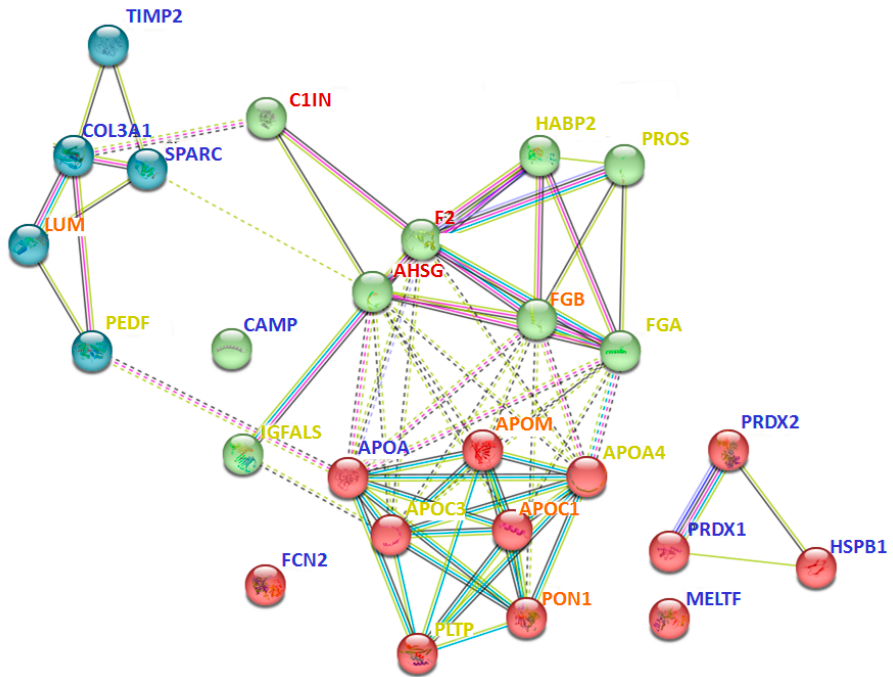
Figure 6. Interaction analysis of some of the potential urinary protein markers prevalent only in certain groups (Table 2), using the STRING method. The red cluster corresponds to different processes associated with lipid metabolism; the green cluster relates to immune processes; the blue cluster corresponds to extracellular matrix organization. The color of the font indicates the predominance of the protein in specific groups: blue—control; yellow—sFSGS; orange—sFSGS and MN; red—MCD, mFSGS, sFSGS, and MN. Abbreviations coincide with the data in Table 2. The more complete information for all prevailing proteins is given in Supplementary Table S5.